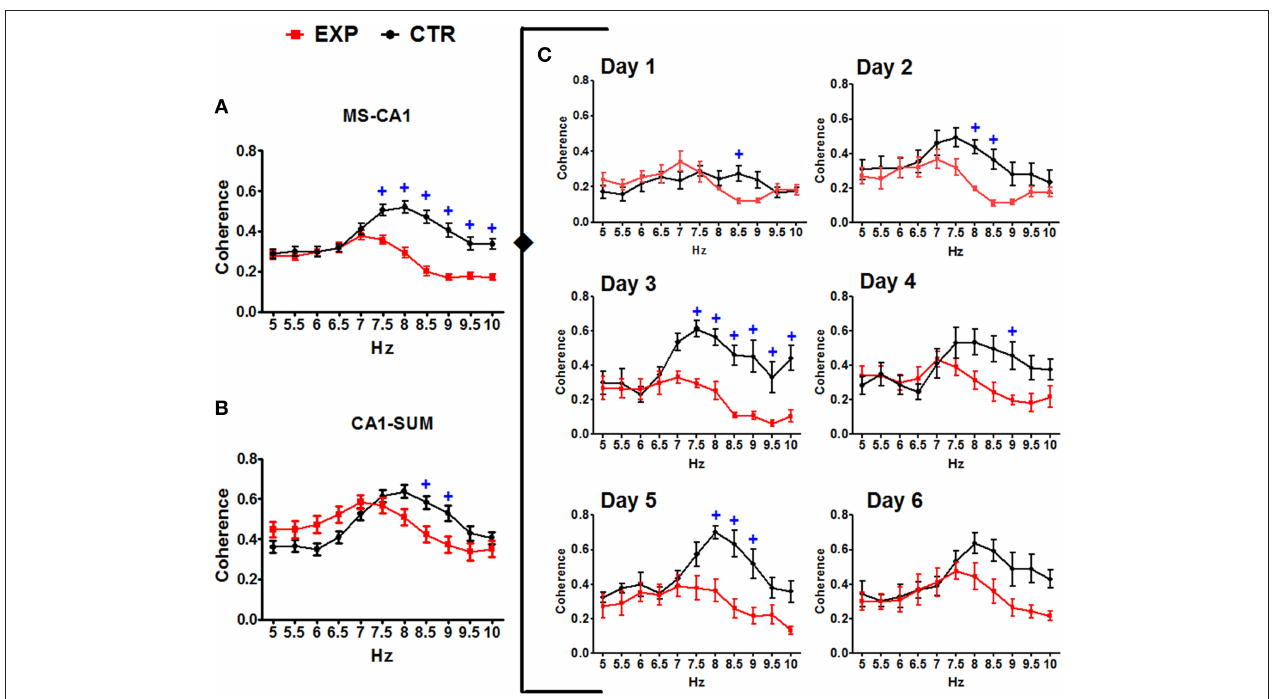
FIGURE 9 | Coherences between the EEG recorded in the MS-CA1 and CA1-SUMn, in the two groups. Inter-group comparisons in the MS-CA1 coherence (A) and in CA1-SUMn coherence (B), were observed (main effect). MS-CA1 coherence was also different through the days of training (C) . Mean ± SEM. + , Group CTR vs. group EXP. p < 0.05